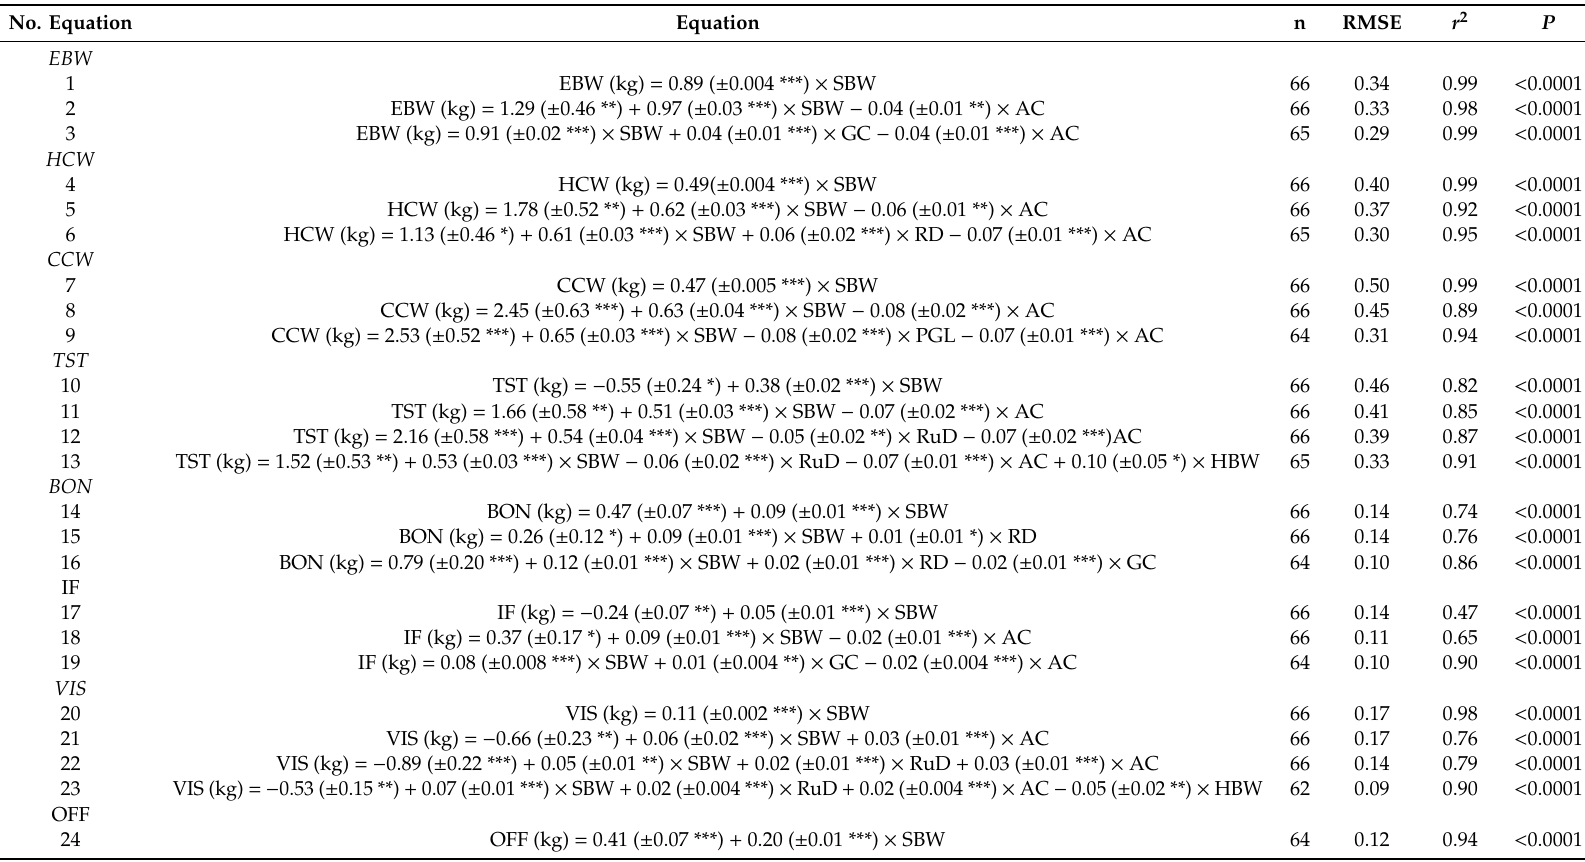
Table 3. Regression equations for prediction of carcass traits in suckling hair lambs using body measurements 1